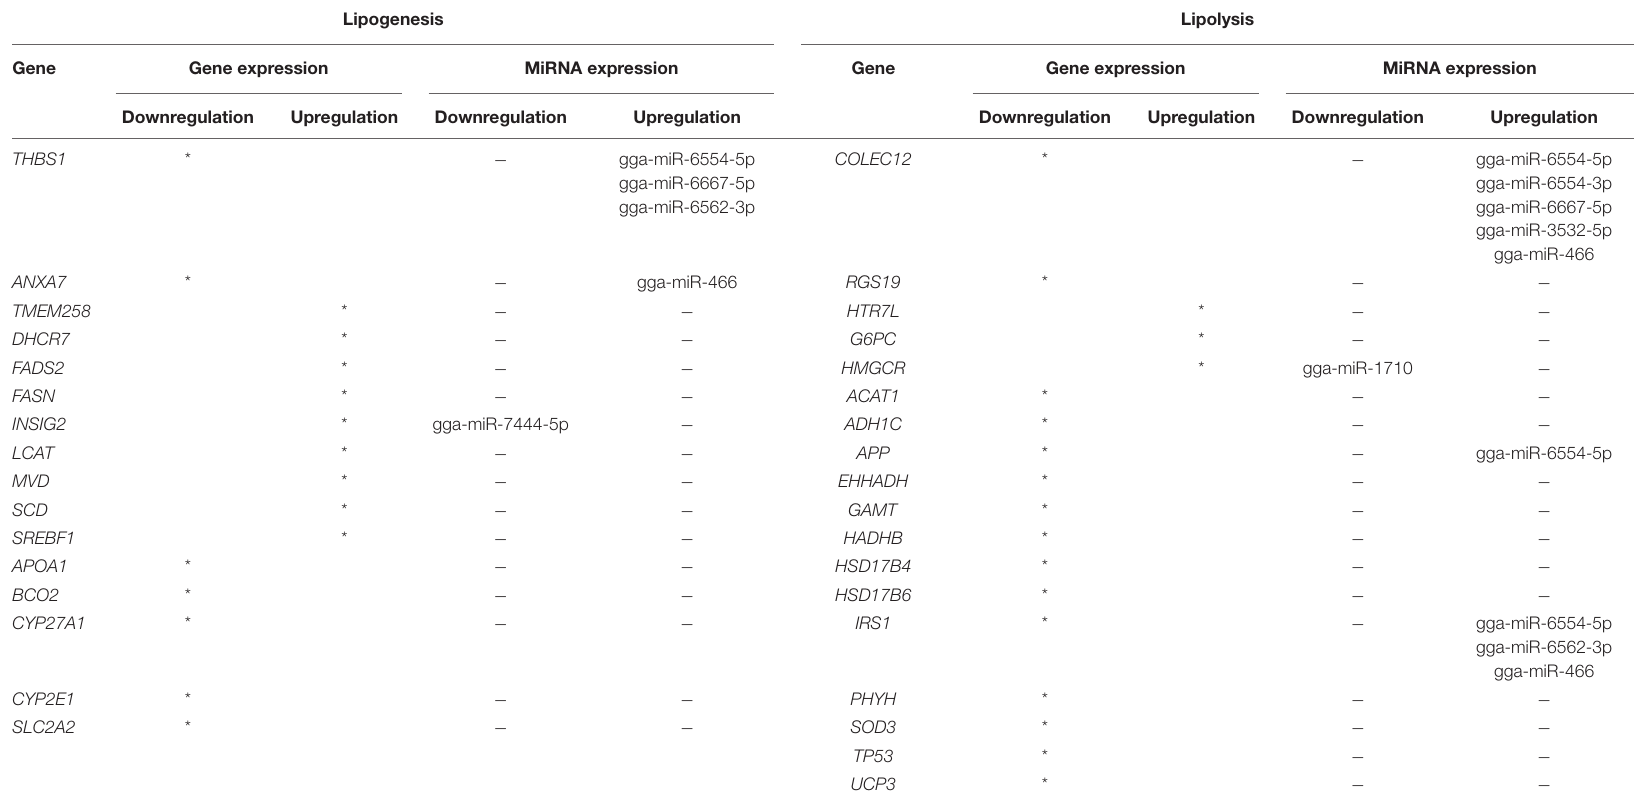
TABLE 2 | Genes and miRNAs, annotation, and genes involved in lipogenesis and lipolysis.